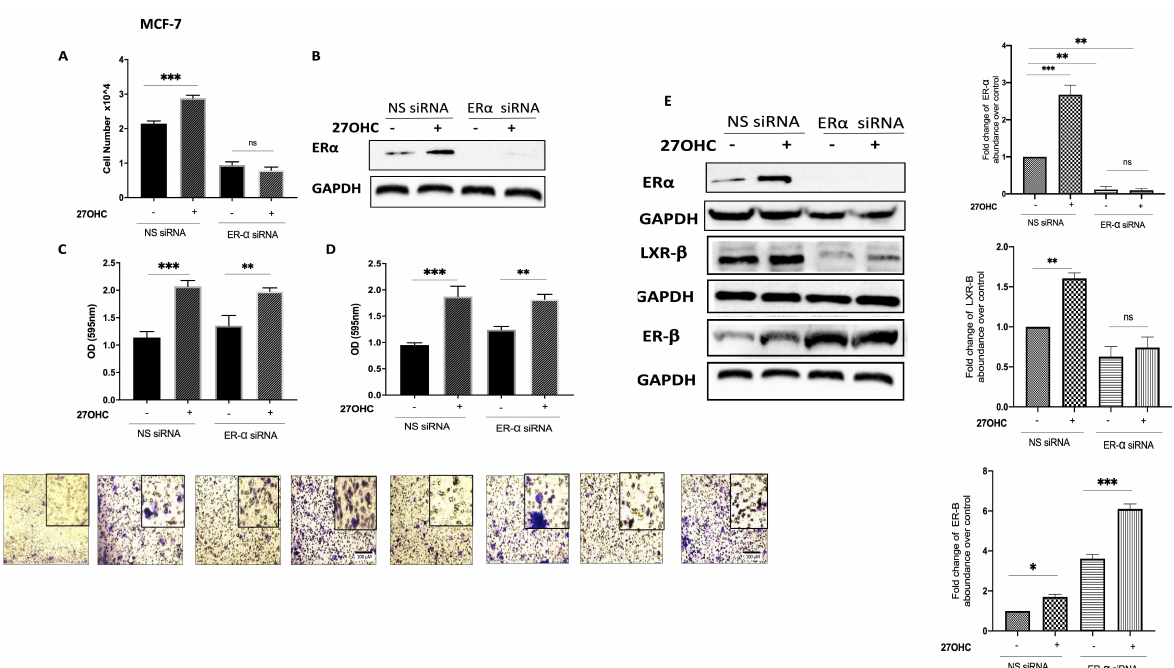
Figure 3. Effects of 27-hydroxycholesterol on cell growth and migration/invasion in the presence or absence of ER- α . Using the Muse cell analyser, we assessed the cell number for ( A ) MCF-7 after being transfected with ER- α siRNA (20 nm) and non-silencing RNA (20 nm) and dosed with 27OHC (0.1 µ M) for 48 h. ( B ) Western immunoblot analysis was performed to show the protein abundance of ER- α in MCF-7 with or without ER- α silencing and 27OHC. β -Actin was used as a loading control. A trans-well migration/invasion assay was used for the migrated cells after 24 h, the cells were stained with crystal violet, and images were taken ( × 20 magnification). We quantified ( C ) cell migration and ( D ) invasion in MCF-7 cells after being transfected with ER- α siRNA and dosed with 27OHC. ( E ) Densitometry of the Western blot showing the protein abundance of ER- α , LXR- β , and ER- β after normalization to the reference protein GAPDH and B-actin. p -values were determined by using the one-way statistical analysis of GraphPad Prism: ANOVA test plus least significant difference (LSD) post-hoc test (* p <0.05, ** p < 0.01, *** p <0.001). Scale bar represents 100 µ